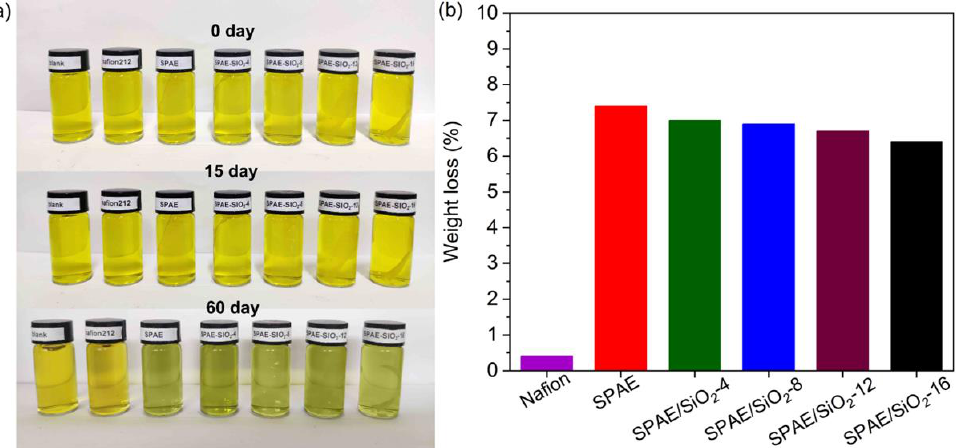
Figure 7. ( a ) Digital photos of Nafion 212, SPAE, and SPAE/SiO 2 composite PEMs in 1.0 M VO 2+ + 2.0 M H 2 SO 4 solution at the 0, 15, and 60 days; ( b ) weight loss of Nafion 212, SPAE, and SPAE/SiO 2 composite PEMs after 30 days of